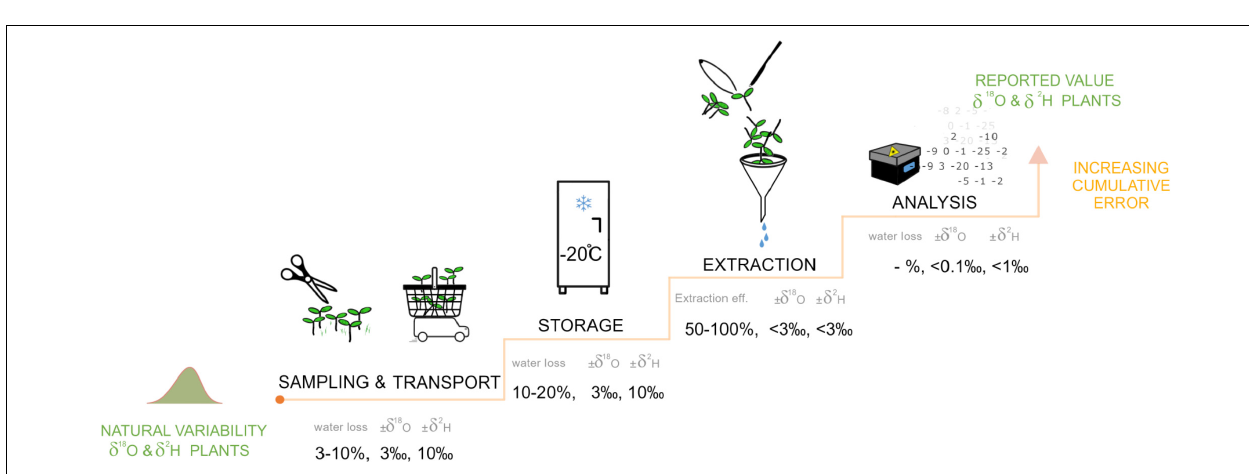
, respectively. With each step the (cid:104)